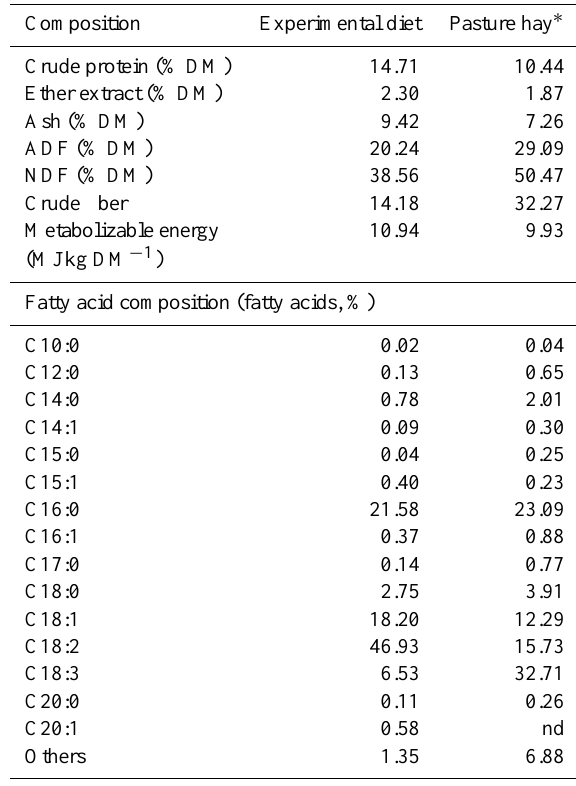
Table 1. Chemical composition of concentrate and pasture